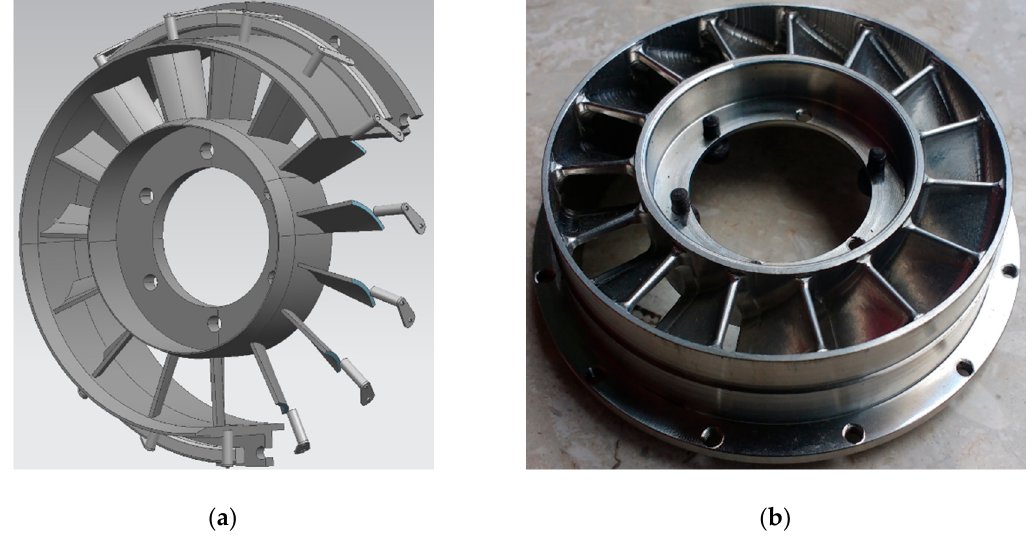
Figure 4. Researched adjustable turbine nozzle system: ( a ) 3D model of the variable geometry system; ( b ) manufactured nozzle with modified geometry (nozzle angle inclination increased +5°).